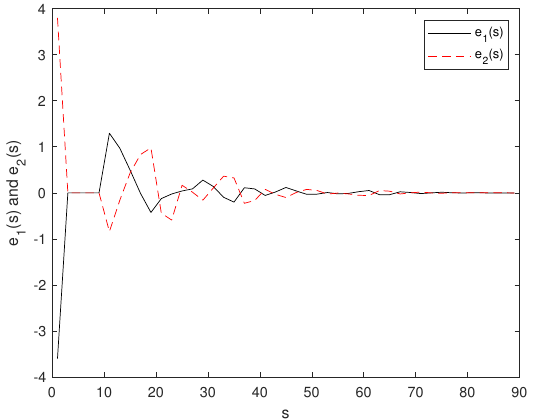
Figure 11. Trajectory curve of an error system e ( s ) with controller.